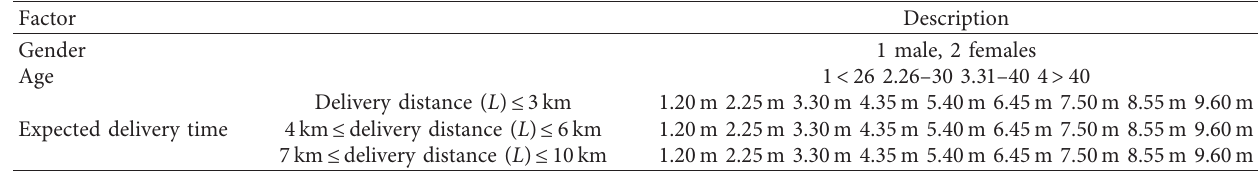
Table 3: Questionnaire about expected delivery time.